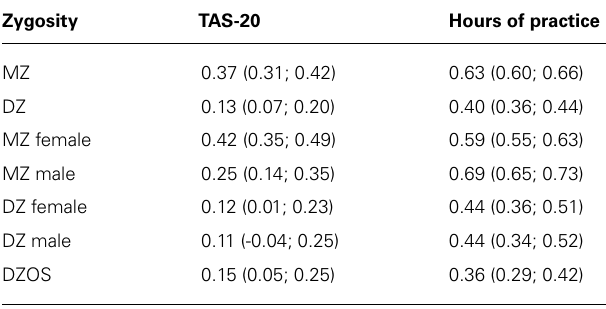
FIGURE 2 |Age adjusted marginalTAS-20 means for ensemble (yes/no) and music practice tertiles among subjects (women) who have practiced playing an instrument. Music practice tertiles: lower, range 40–800, median 440, Middle, range 840–2360, median 1360, Upper, range 2400–20800, median 5040.